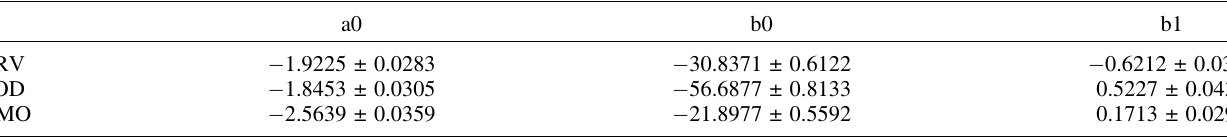
Table 1. Results of the metropolis method for Equation